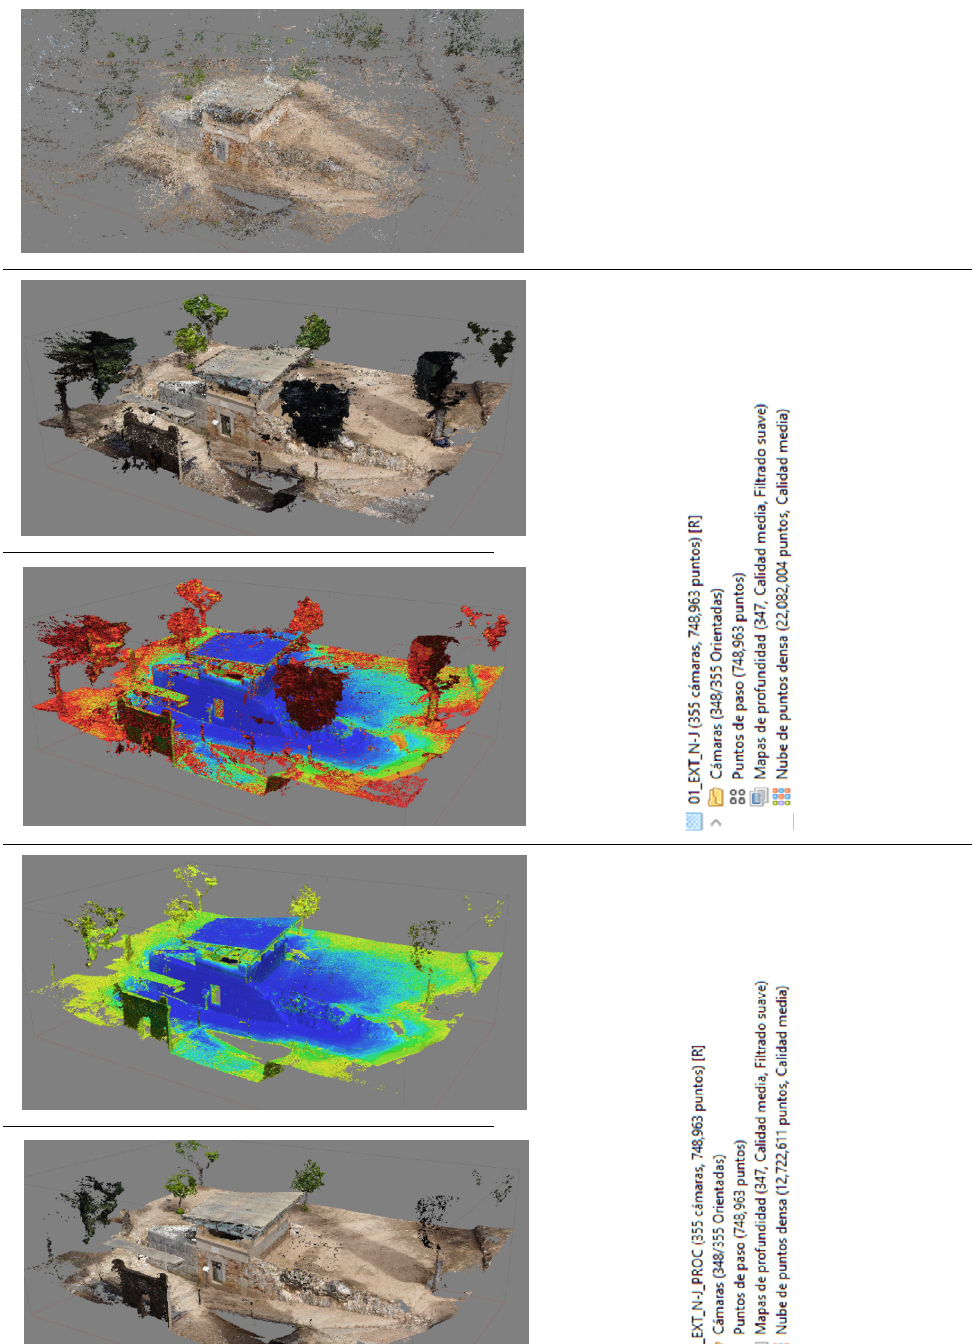
Table 5. Point cloud generation process in Photoscan of the exterior of the Niger and Julios build- ings.